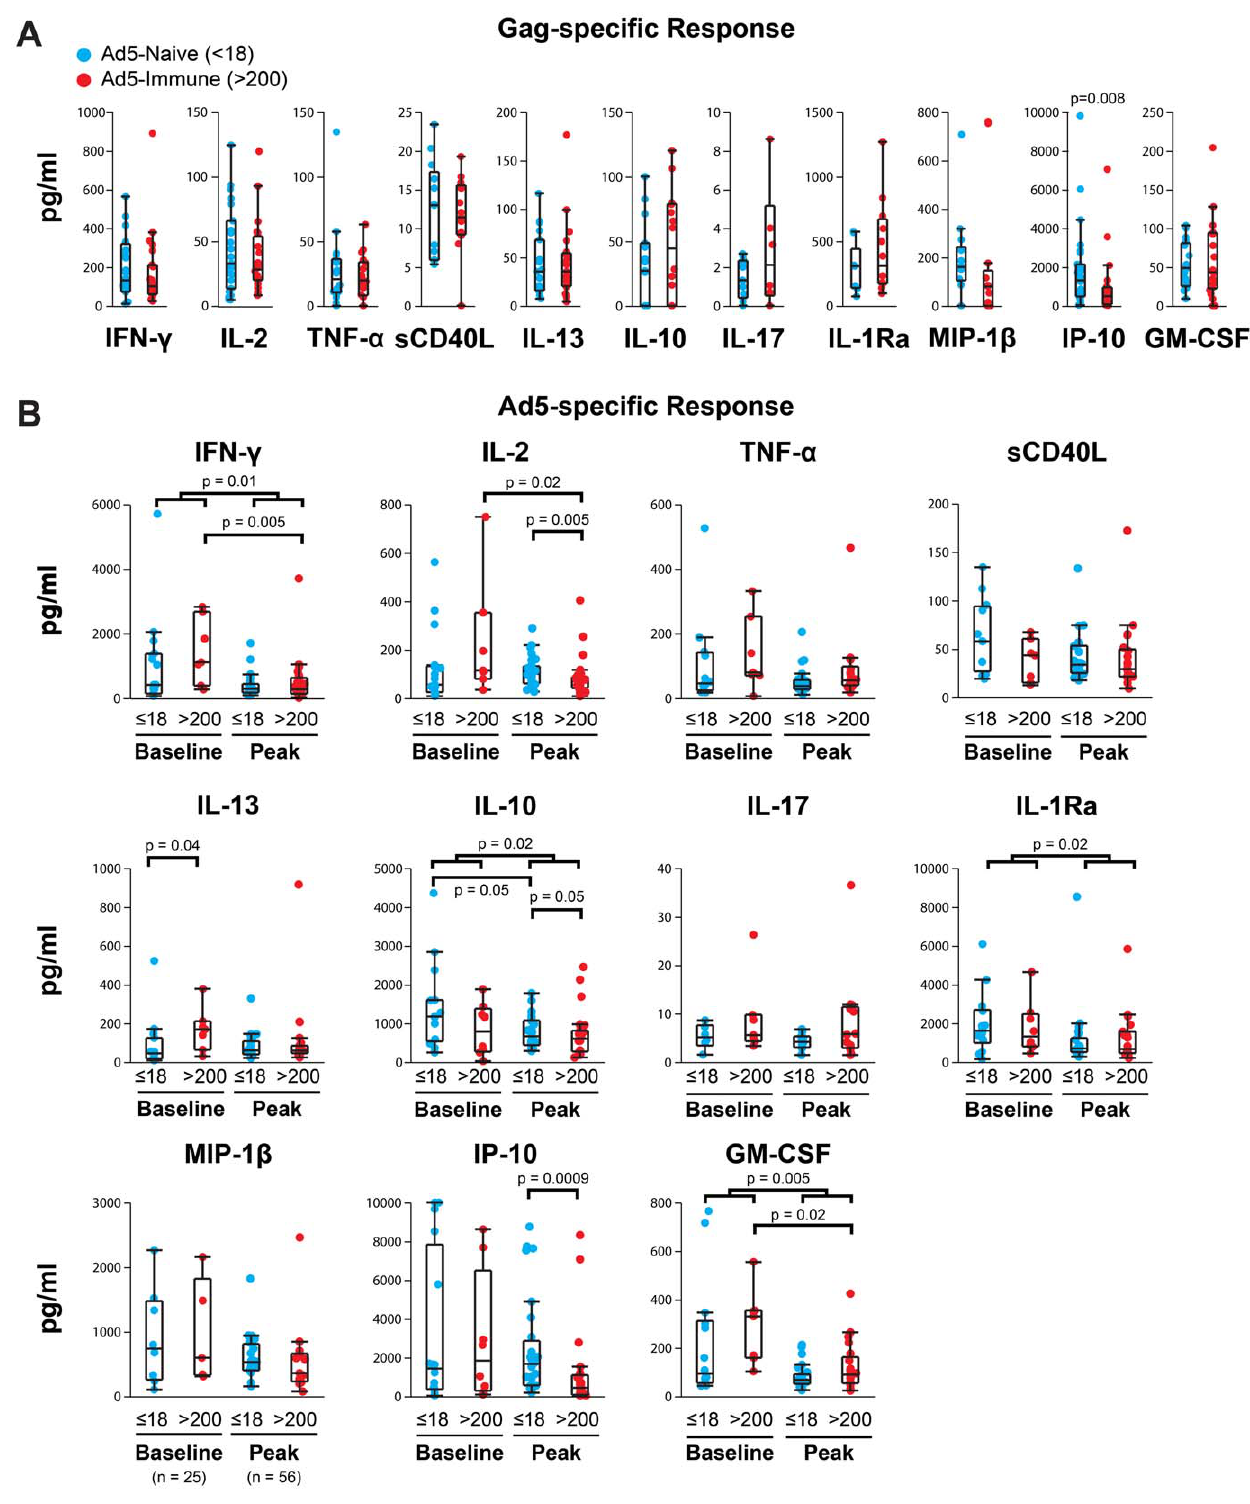
Figure 2. Comparison of Gag- and Ad5-specific cellular responses in Ad5-seronegative and Ad5-seropositive vaccinees. PBMC from vaccinees collected at a peak timepoint (28 weeks) were tested by multiplex cytokine assay. Background-subtracted concentrations of a focus set of eleven analytes are shown for Ad5-seronegative (blue) and Ad5-seropositive (red) test groups stimulated by either (A) a Gag PTE peptide pool or (B) Ad5 empty vector. Only positive responders, as reported in Table 2, were included in the analyses. Box and whisker plots indicate median and interquartile ranges, and groups were compared by Wilcoxon rank sums. Probability estimates are indicated when p # 0.05.